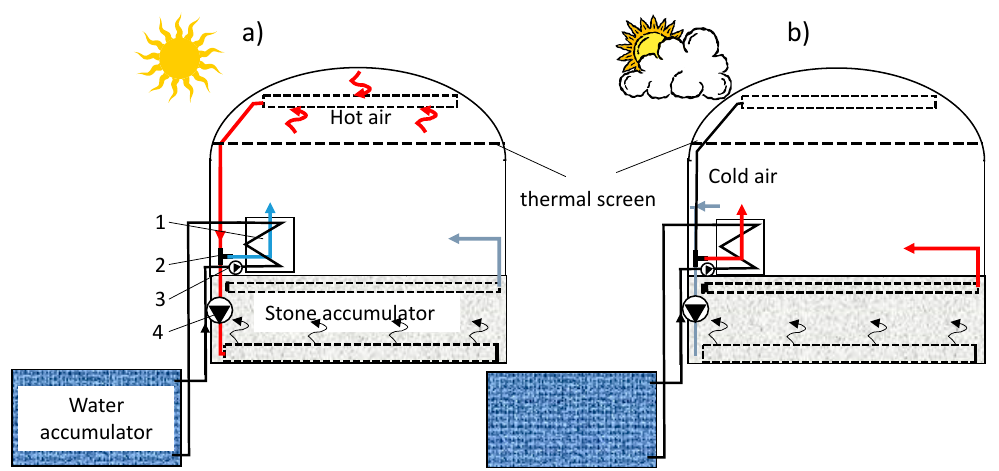
Figure 1. Schematic diagram of the analyzed stone-bed and water accumulator system during the charging ( a ) and discharging cycle ( b ).